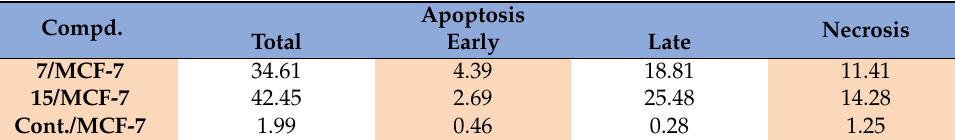
Table 3. Apoptosis and necrosis data on MCF-7 cells induced by the most potent derivatives 7 and 15 . Apoptosis Compd. Total Early